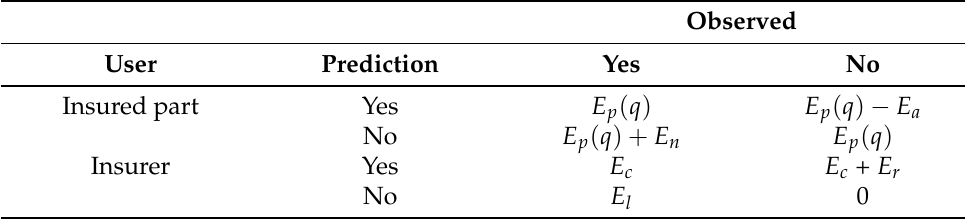
Table 5. Cost of events for the